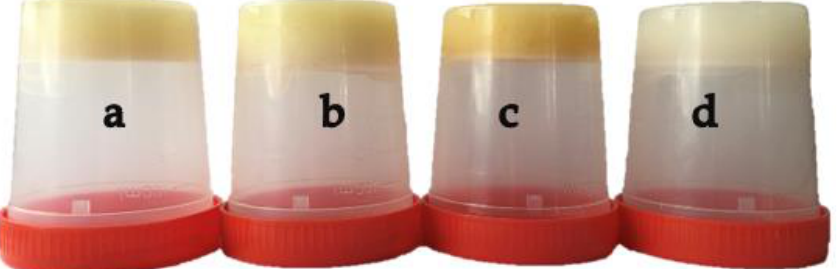
Figure 1. Visual appearance of ( a ) oleogel with carnauba wax (OG_CRW), ( b ) oleogel with β -sitosterol:beeswax (OG_BS:BW), ( c ) oleogel with β -sitosterol:lecithin (OG_BS:LEC), and ( d ) oleogel with glycerol monostearate (OG_GM).